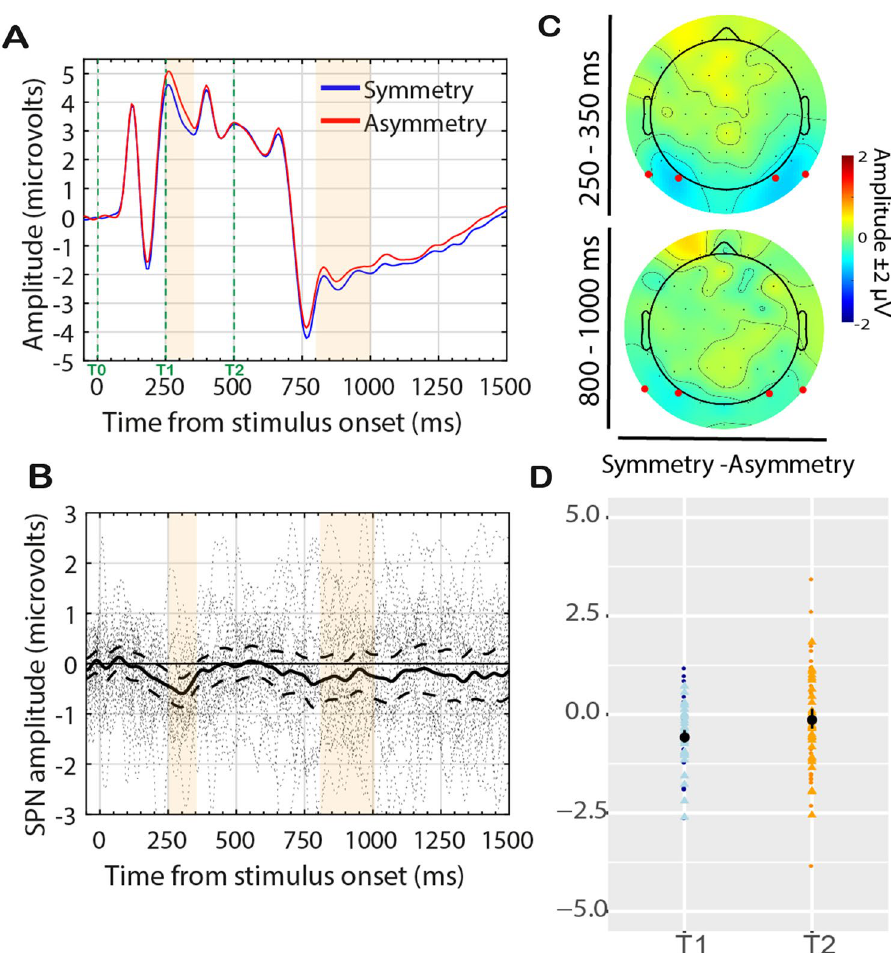
Figure 9. Experiment 4 results. Conventions are the same as Figs. 3, 5 and 7, except there is no Same and Novel distinction in Experiment